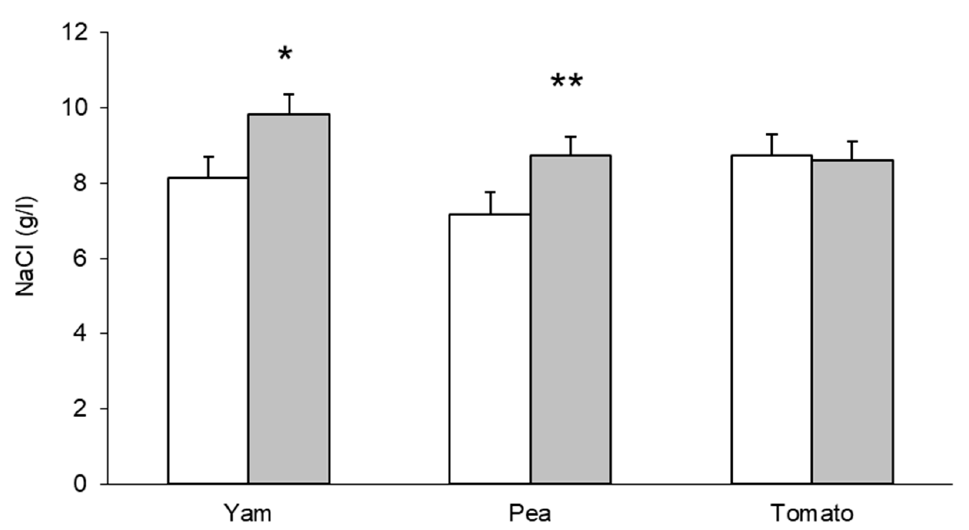
Figure 6. Sex difference in preferred salt concentration in soups. Women, white columns, men, grey columns, n = 41–110/column, * p > 0.02, ** p < 0.005, From [108].